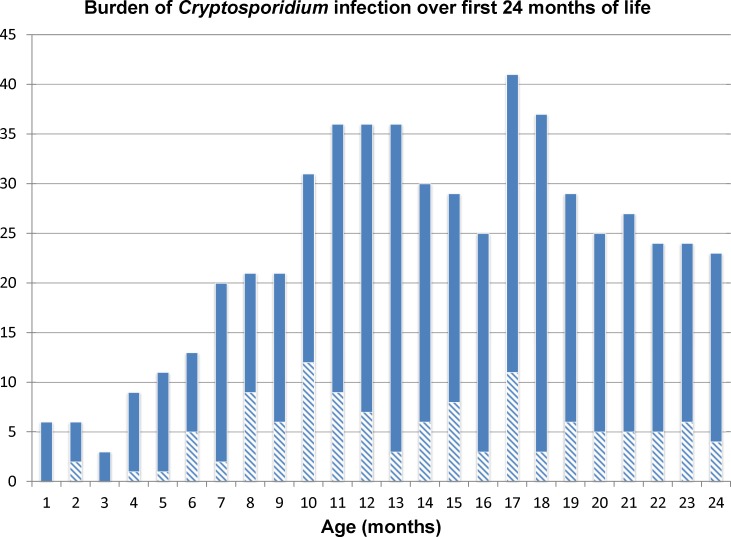
Total number of children with Cryptosporidium infection per month.The x-axis represents age of the child in months, and the y-axis represents total number of infected children per age-month. The solid-segment represents number of children with asymptomatic Cryptosporidium infection, and the lined-segment represents number of children with diarrhea from Cryptosporidium infection. In each month, the total possible number of children included is 392. A child who had both a diarrheal and asymptomatic stool positive in the same month was counted as having Cryptosporidium diarrhea. This figure demonstrates peaks of diarrheal Cryptosporidium infection at 10 and 17 months of age, and peaks of asymptomatic infection at 10–13 and 17 months of age.